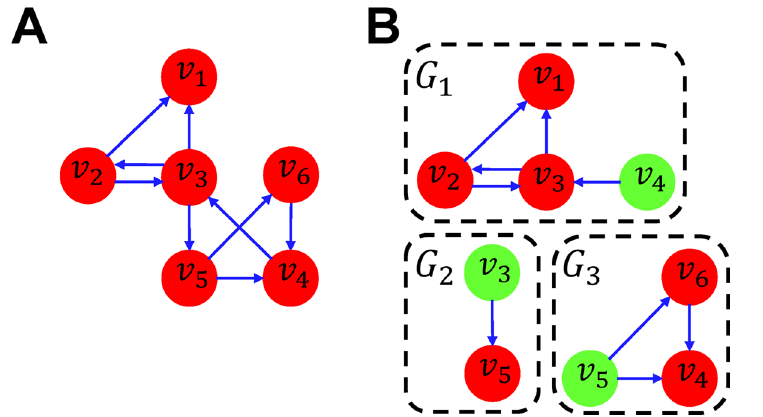
Fig 2. A division into three subnetworks. A: A Boolean network model G . B: A division into three subnetworks ( e.g., G 1 , G 2 , and G 3 ). Input nodes are depicted as green nodes.